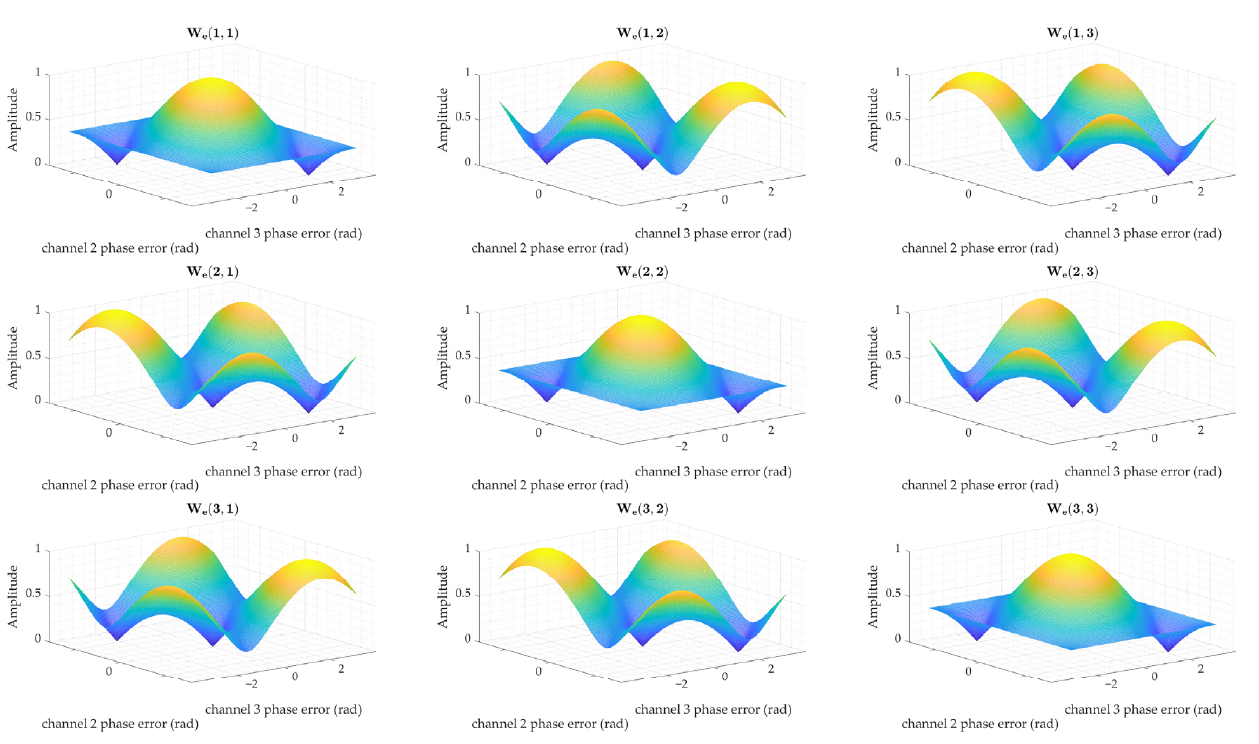
Figure 4. Weighted matrices affected by different phase errors.